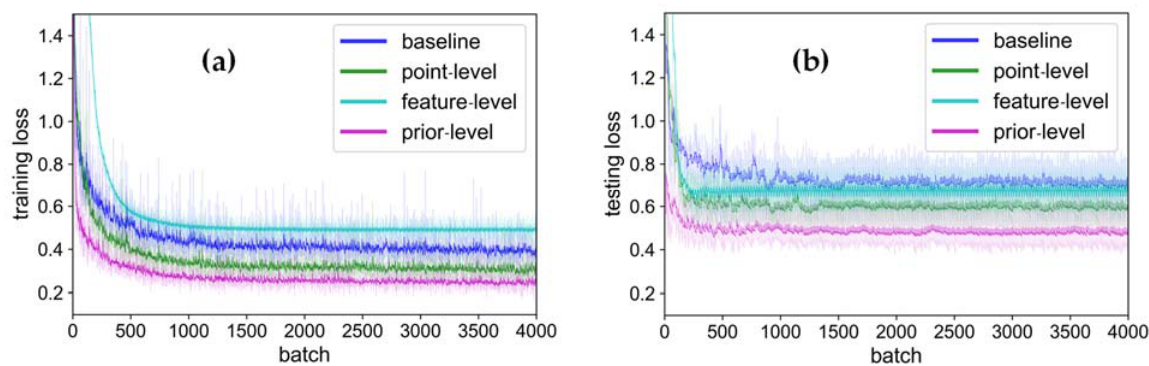
Figure 7. Training loss ( a ) and testing loss ( b ) during PointNet++ training. Losses were smoothed using the exponential moving average method TensorBoard.